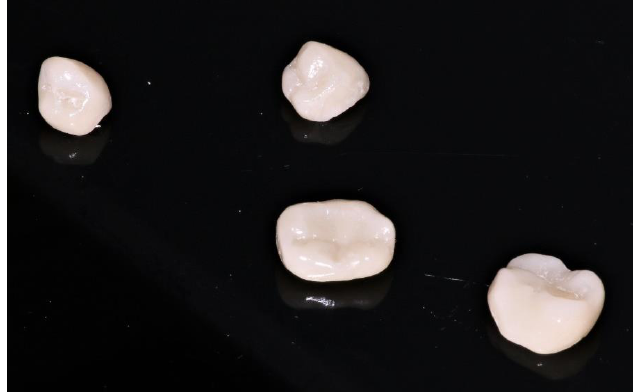
Figure 11. Fixed prosthetic elements traditionally glazed and polished.